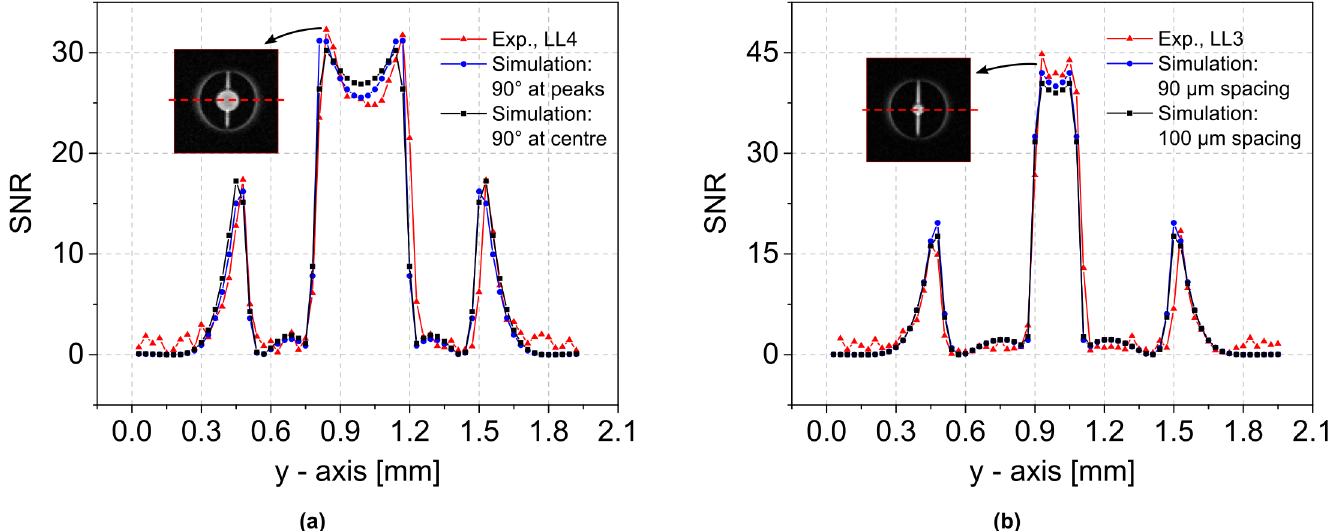
Fig 4. SNR line profiles to compare the measurements and the model developed above as well as to verify the influence of design parameters. (a) Comparisonof the measured SNR profile for LL4 and the simulatedSNR profiles for two differentlydefined90˚-pulses:at the highest signalintensity in accordance with the experiment; at the centre-pointof the arrangement. (b) Measuredand simulatedSNR profiles for LL3 at the 90˚-pulsepower. Simulated profiles were calculatedfor two different lens spacings(90 μ m and 100 μ m), whilein both cases, the 90˚-pulsewas definedat the centre-point.